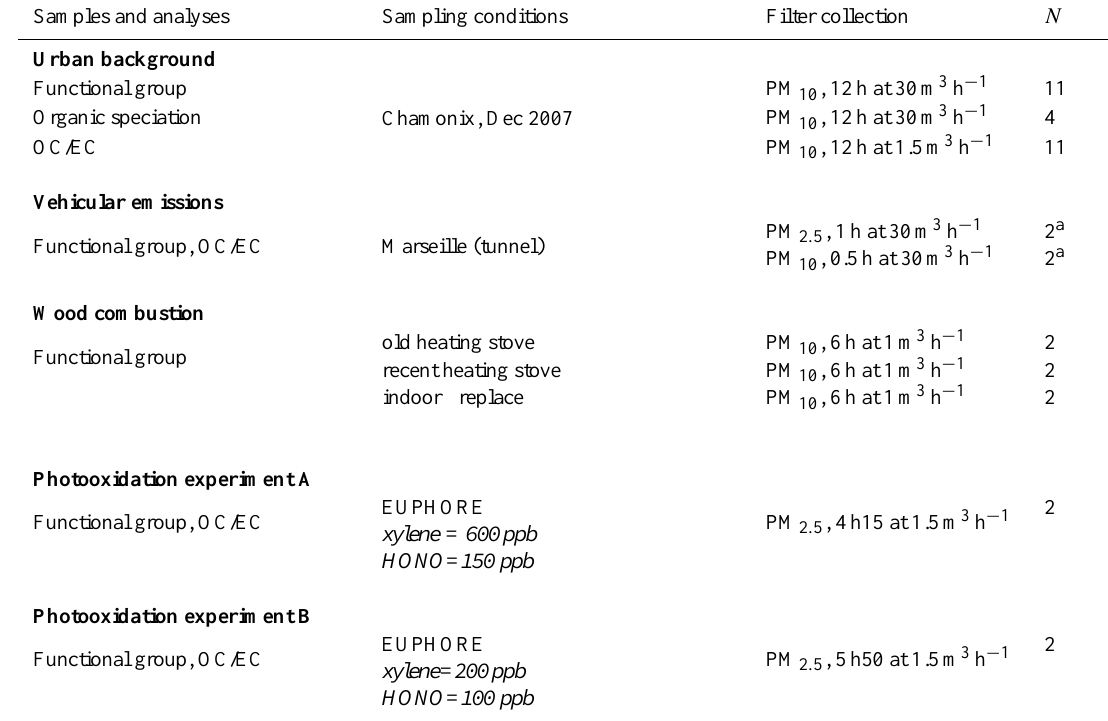
Table 1. Overview of the samples under study: analyses performed, sampling conditions and number of filters collected ( N ) for each